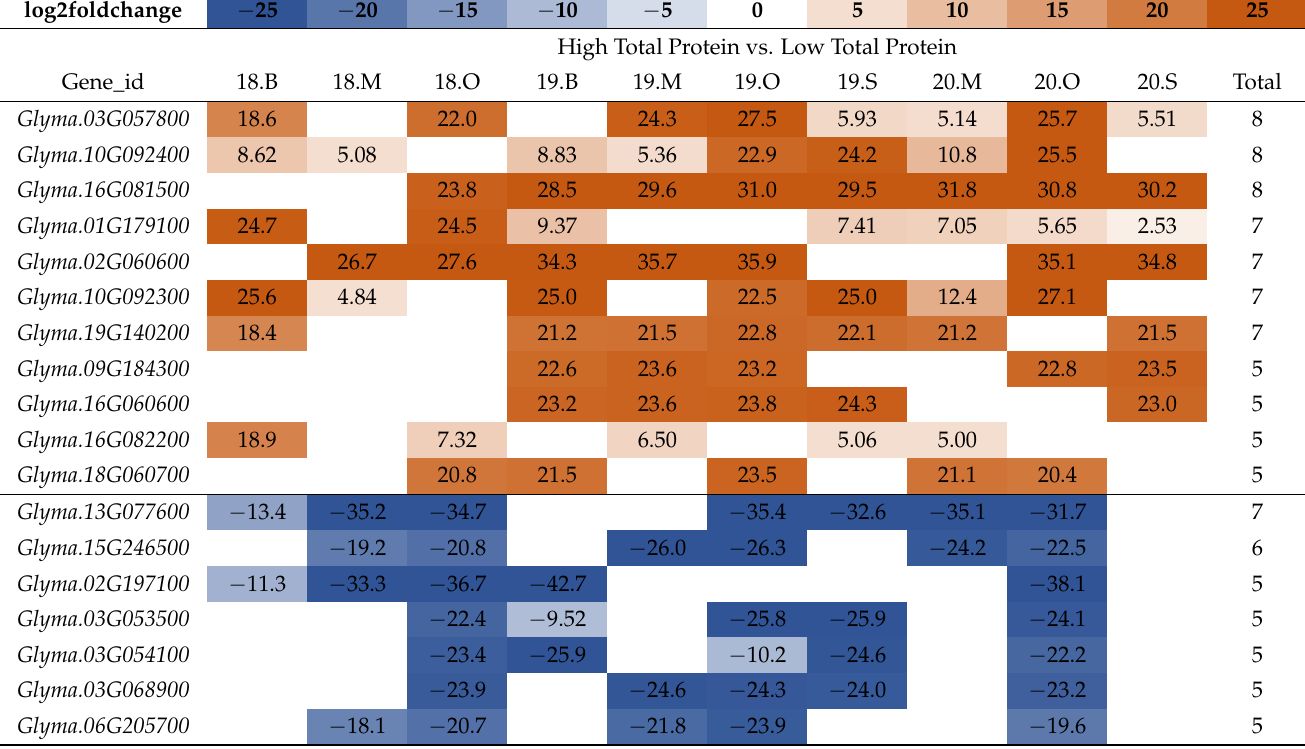
Table 2. The log2FC DE between low TP soybeans (lines 1, 2, 3) and high TP soybeans (lines 8, 9, 10) from 2018–2020 over 4 different locations. The top 15 most upregulated and 15 most downregulated genes from each DE analysis were selected. Genes DE in at least 5 of 10 datasets are shortlisted here including the log2FC DE in the high seed protein samples. The 10 DE datasets are identified by their Year-Location shorthand; as an example, 18.B indicates DE of high vs. low 11S soybeans in 2018 from Brandon. O, Ottawa; M, Morden; B, Brandon; S,